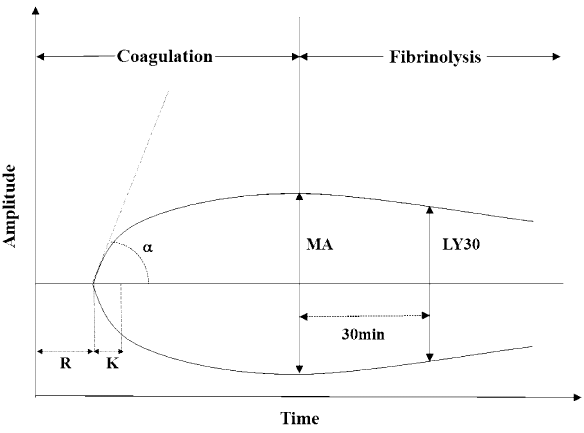
Figure 1. Diagram of TEG. TEG thromboelastography; R reaction time; K kinetic time; MA maximal amplitude; α alpha angle; LY30 percentage of lysis after 30